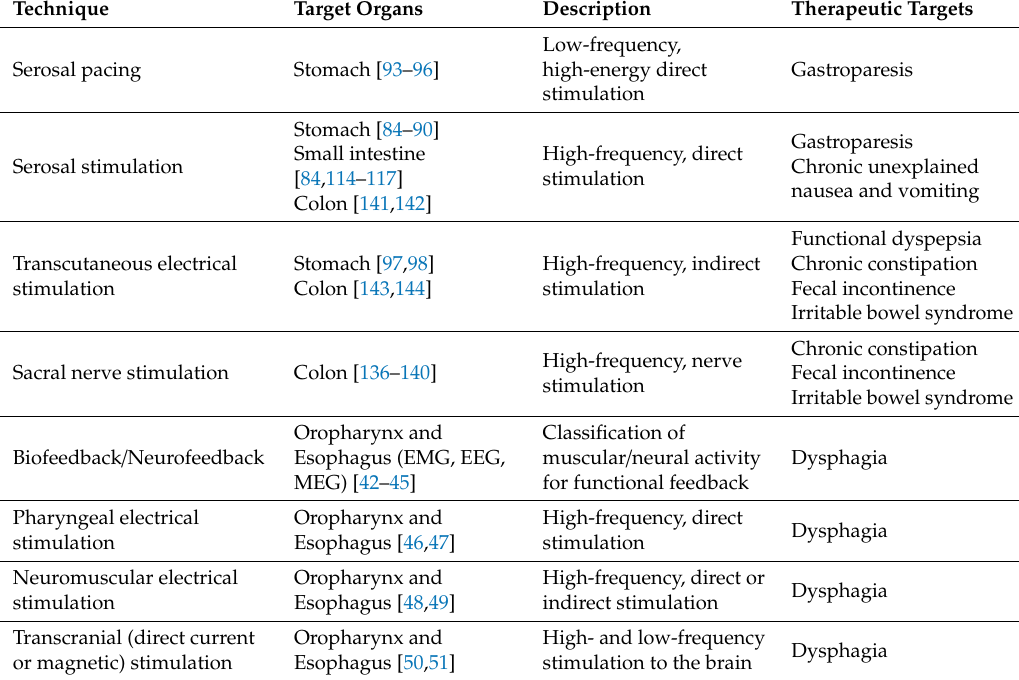
Table 2. Bioelectrical therapies for functional gastrointestinal disorders (FGIDs).